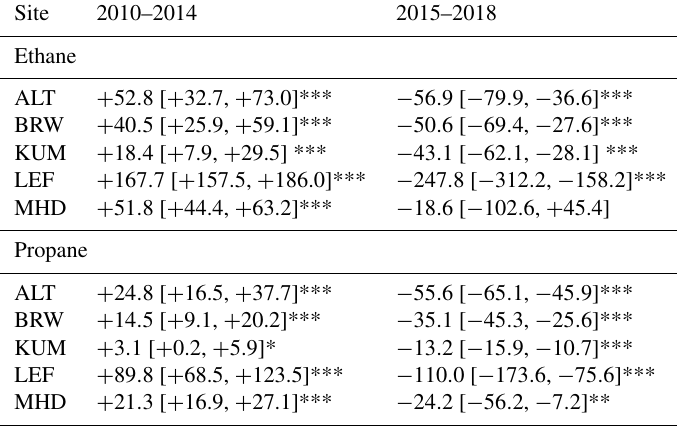
Table 1. Rates of change and 95% confidence interval (in brackets) inferred from discrete flask sampling (in pptyr − 1 ). ALT, BRW, MHD, LEF, and KUM refer to Alert, Utqia˙gvik (formerly Barrow), Mace Head, Park Falls, and Cape Kumukahi. The localization of the sites can be found in Fig. 1. The symbols shown next to each rate of change relate to how statistically significant the estimate is: p< 0 . 001 = ***, p< 0 . 01 = **, and p< 0 . 05 =